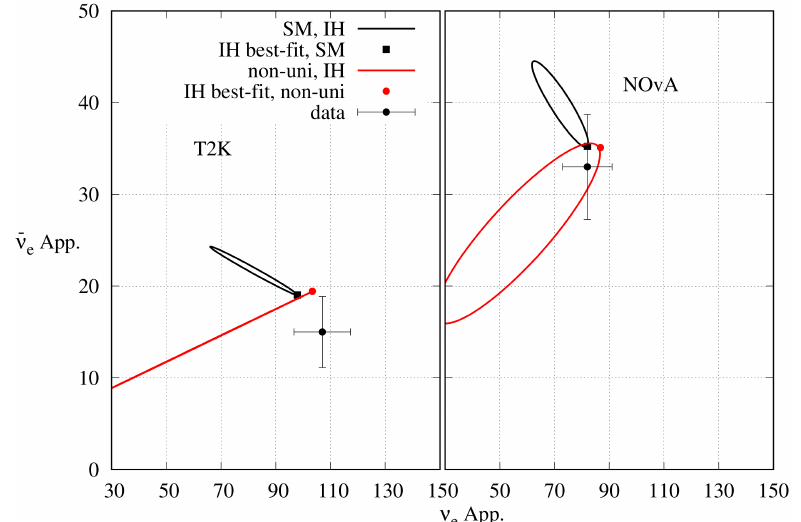
Figure 9. Bi-event plot for T2K (NO ν A) in the left ( right ) panel. The upper ( lower ) panel is for NH (IH). To generate the ellipses, δ CP has been varied in the range [ − 180 ◦ :180 ◦ ] while keeping all other parameters at their combined best-fit values. The black (red) ellipses represent the SM (non-unitary) case with the best-fit points indicated by the black square (red circle). The ellipses and the best-fit points have been determined by fitting the combined data from NO ν A and T2K. The black circle with error bars represent the experimental